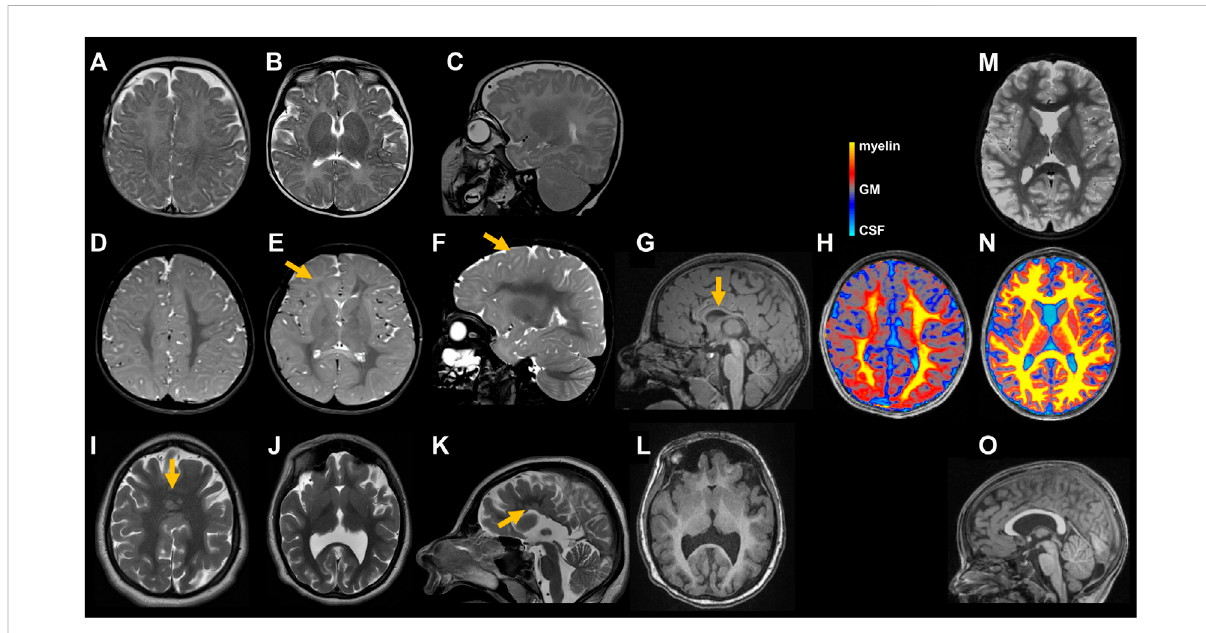
FIGURE 2 Cranial images of individuals with STAG2 -associated cohesinopathy. Individual 1 underwent MRIs at age 5 months (A – C) and 5 years and 4 months (D – G) .Minordelayof myelination can beseen on theinitial axial (A,B) and sagittal (C) T2 weighted (T2w)images. At 5 years and 4 months, myelination is still incomplete as illustrated in axial (D,E) and sagittal (F) T2w images affecting peripheral white matter regions [indicated by yellow arrow in (E) ] and U- fi bers [indicated by yellow arrow in (F) ]. Right hemisphere appears hypotrophic (D,E) . T1 weighted (T1w) sagittal image (G) shows a thin and dysplastic corpus callosum [indicated by yellow arrow in (G) ]. Axial magnetization transfer saturation (MTsat) map (H) : Semi- quantitative MRImarkerfor myelindepicts amyelin de fi cit, pronounced inperipheralwhitematter andU- fi bers. Color scale represents MTsat values withhighestvalues(yellow)foundinmyelinandgraduallydecreasingtograymatter(GM)(grey)andcerebrospinal fl uid(CSF)(turquoise).Fordetailed description ofMR methods see (Dreha-Kulaczewski et al., 2012) (H) . MRI of individual 2 atage 17 years and 2 months reveals normal myelination but profoundmalformationsincludingmultipleperiventricularnodulargraymatterheterotopiasandasemilobarholoprosencephalyasillustratedinaxial (I,J) andsagittal (K) T2wimagesaswellasaxialT1wimage (L) includingmultipleperiventricularnodulargraymatterheterotopias[indicatedbyyellow arrowin (K) ]andasemilobarholoprosencephaly[indicatedbyyellowarrowin (I) ].Cranialimagesfromage-matchedhealthyindividuals (M – O) .Axial T2wimages (M) showsfullymyelinatedwhitematterincludingthesubcorticalU- fi bers.MTsatmap (N)